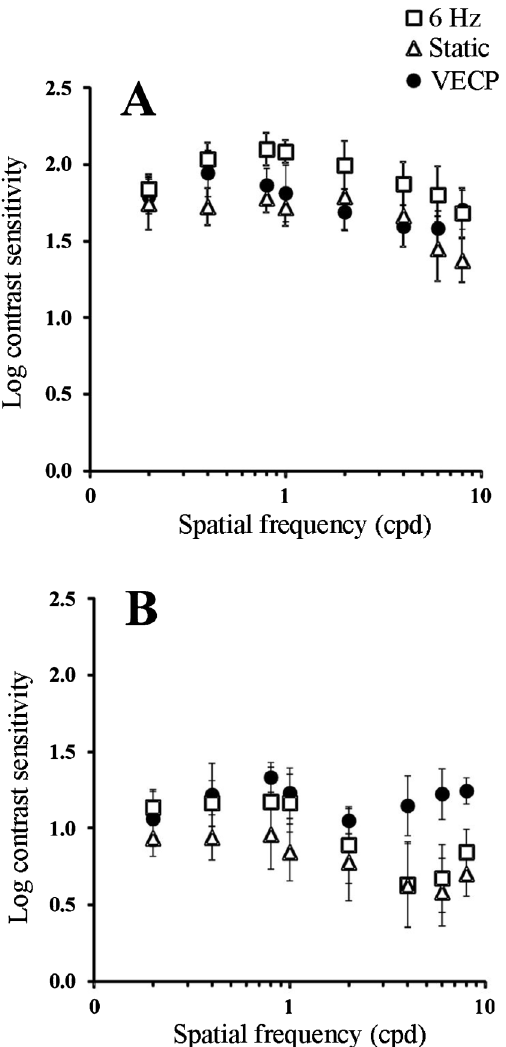
Figure 3. Contrast sensitivity to red-green ( A ) and blue-yellow ( B ) sinusoidal gratings obtained as the inverse of contrast thresholds estimated for 6 normal trichromat subjects. Data are reported as means ± SD for 6 subjects. Filled circles and empty triangles are contrast sensitivity data from visual evoked cortical potential (VECP) and psychophysics using the same temporal parameters as in VECP, respectively. Empty squares are contrast sensitivity data from psychophysics using the same gratings but static presentation. Contrast sensitivity values measured with ssVEP were compared with each psychophysical procedure and also a comparison between psychophysics tests was made (one-way ANOVA, a = 0.05). When using red-green gratings, ssVEP function was similar to 6-Hz psychophysics but different from static psychophysical contrast sensitivity function (one-way ANOVA, a = 0.05). For blue-yellow gratings ssVECP was different from both psychophysical conditions (one-way ANOVA, a = 0.05). T a